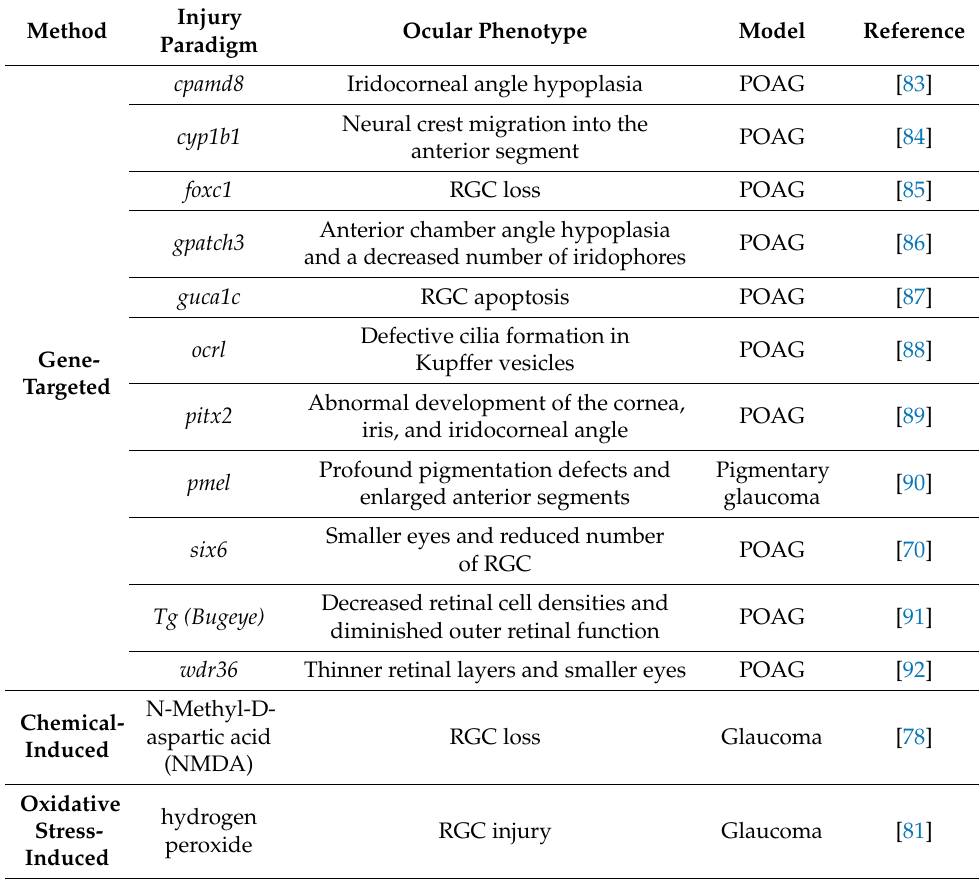
Table 2. Zebrafish models of